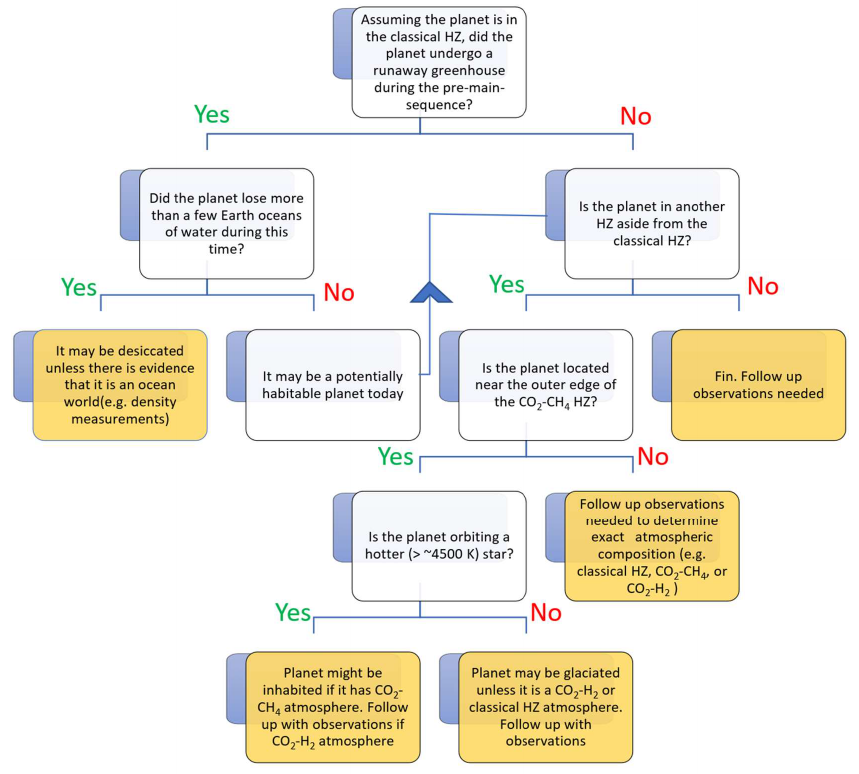
Figure 15. Sample flow chart using the classical HZ, along with CO 2 –H 2 , CO 2 –CH 4 , and pre-main-sequence HZ extensions to assess the potential habitability of planets. End states are in yellow.